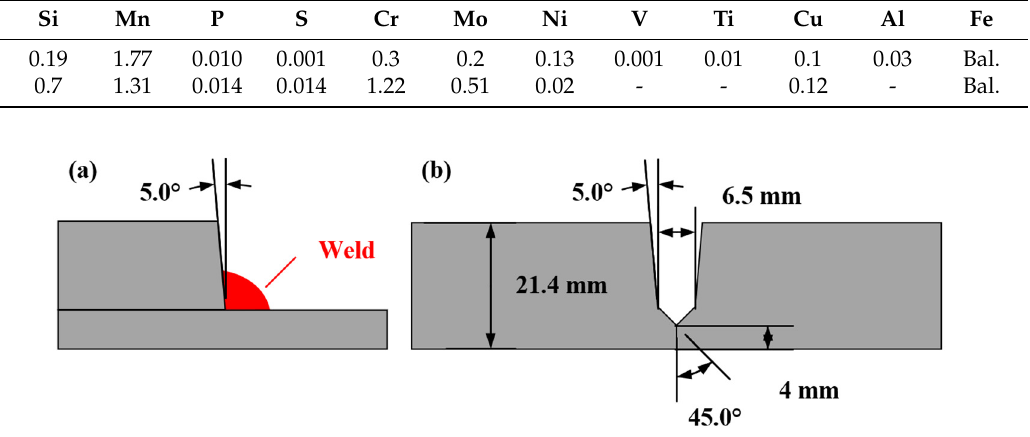
Figure 1. ( a ) Schematic diagram of sidewall fusion experiment; ( b ) schematic diagram of weld groove in the narrow gap welding.